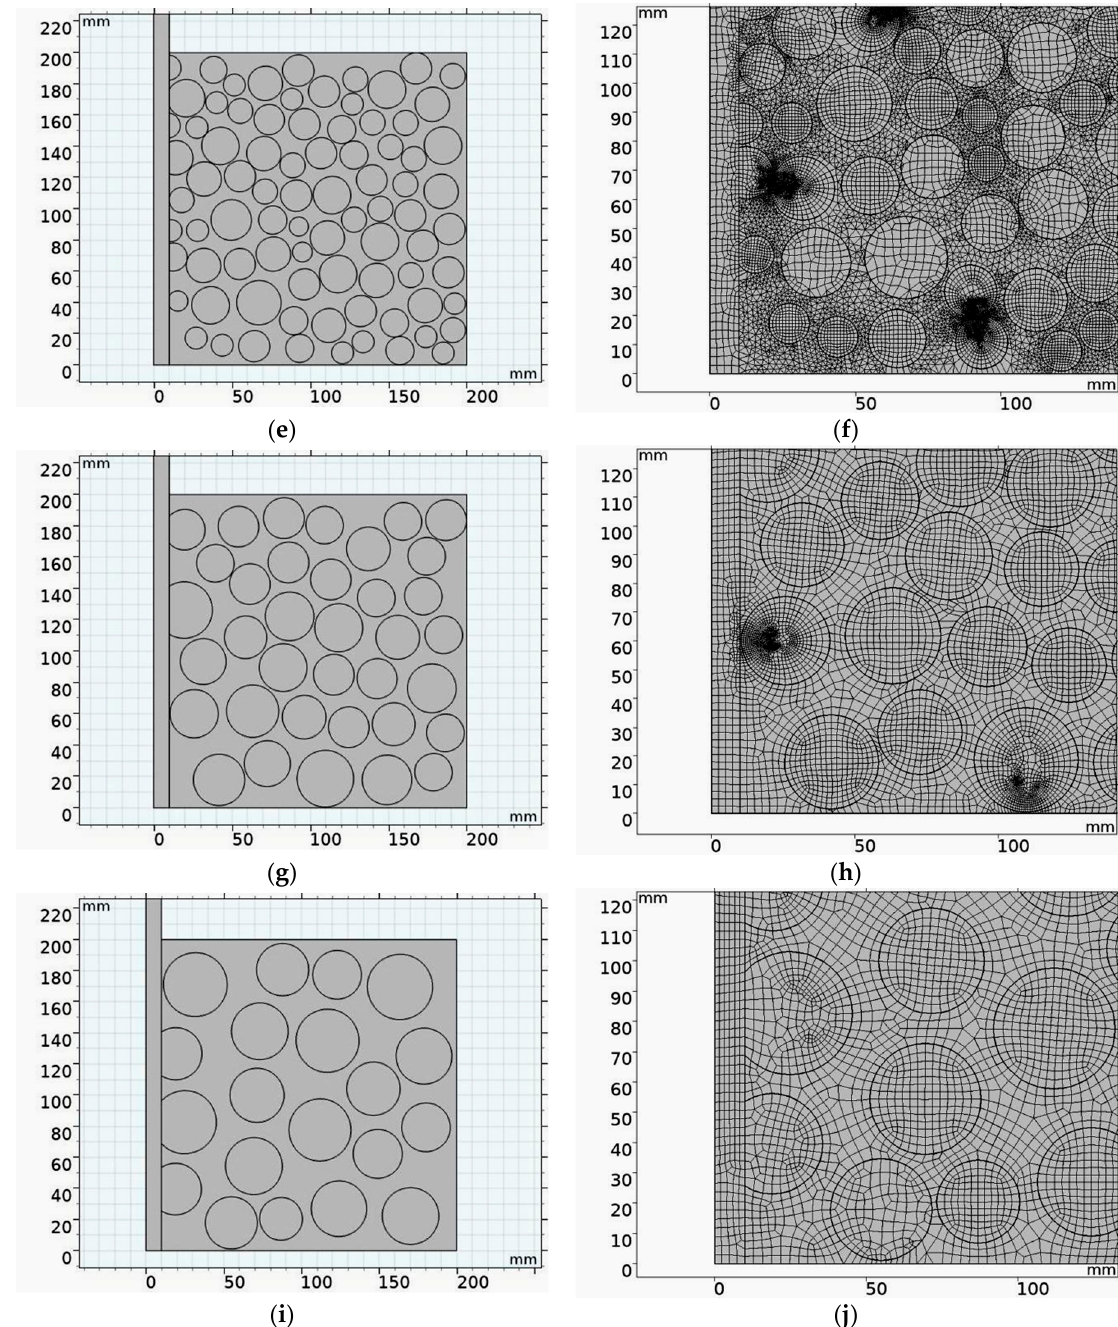
Figure 4. Steam disinfection model. ( a ) <2 mm model; ( b )<2 mm meshing; ( c ) 2–7 mm model; ( d )2–7 mm meshing; ( e ) 7–17 mm model; ( f ) 7–17 mm meshing; ( g ) 17–27 mm model; ( h ) 17–27 mm meshing; ( i ) >27 mm model; and ( j ) >27 mm meshing. Note: The meshing figures are partially enlarged views.